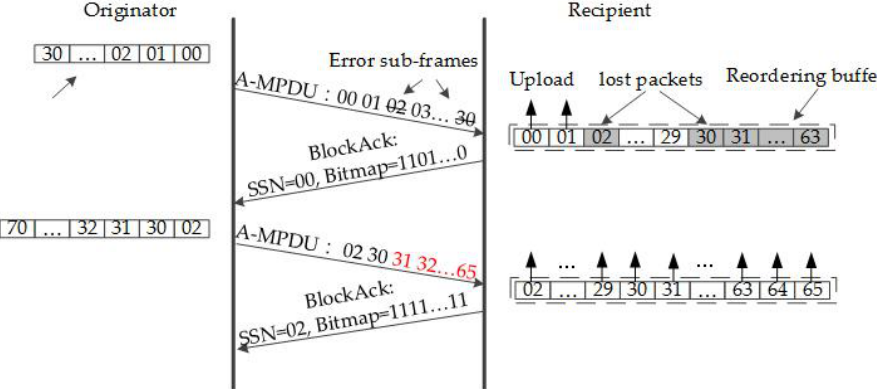
Figure 4. An example of the A-MPDU transmission using the block Acknowledgement window automatic repeat request (BAW-ARQ) scheme where W =